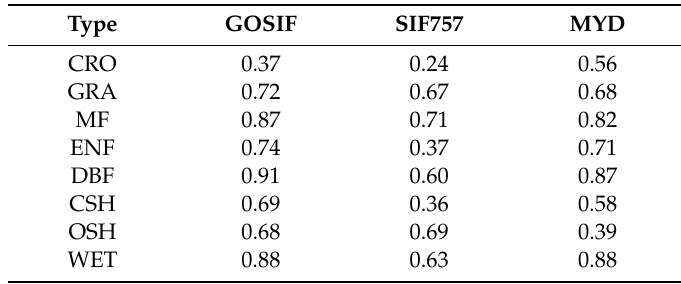
Table 7. Correlation coe ffi cients (R 2 ) of GPP GOSIF -GPP EC , GPP SIF -GPP EC , and GPP MYD -GPP EC models with an extraction range of 25